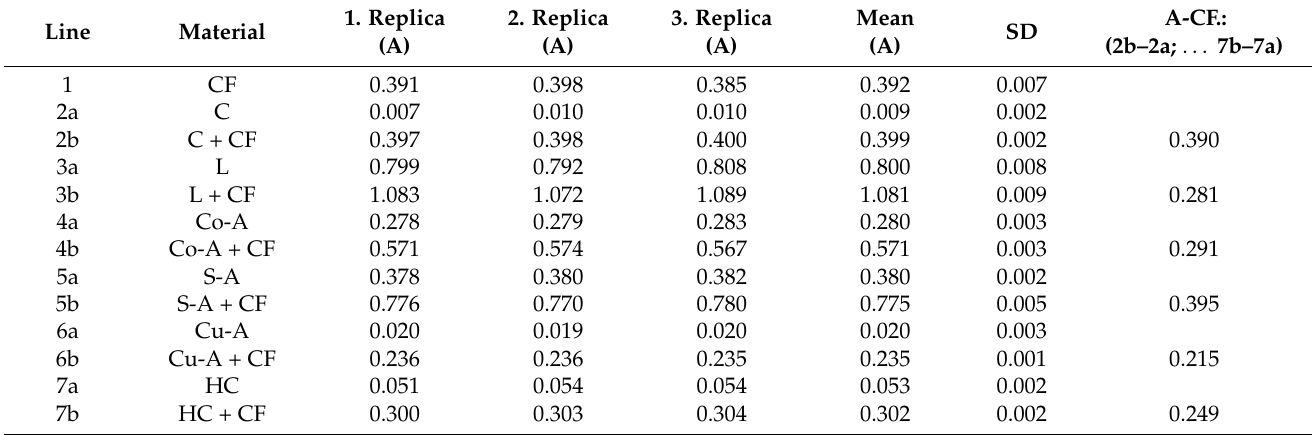
Table 1. Absorbances of tested samples at λ = 287 nm: caffeine (CF), cellulose (C), cellulose + caffeine suspension (C + CF), lignin (L), lignin + caffeine suspension (L + CF), conipheryl alcohol (Co-A), conipheryl alcohol + caffeine solution (Co-A + CF), sinapyl alcohol (S-A), sinapyl alcohol + caffeine (S-A + CF), coumaryl alcohol (Cu-A), coumaryl alcohol + caffeine solution (Cu-A + CF). Primary data ( n = 3), mean values, and their standard deviations (SD). Line